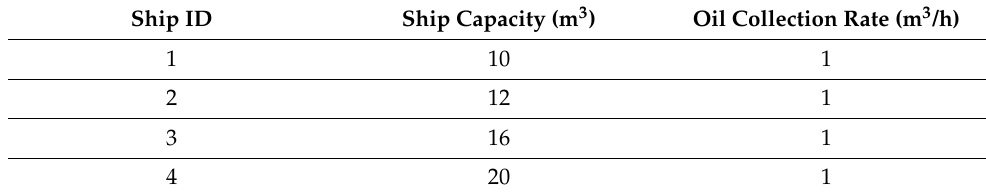
Table 2. Example 1—input data.